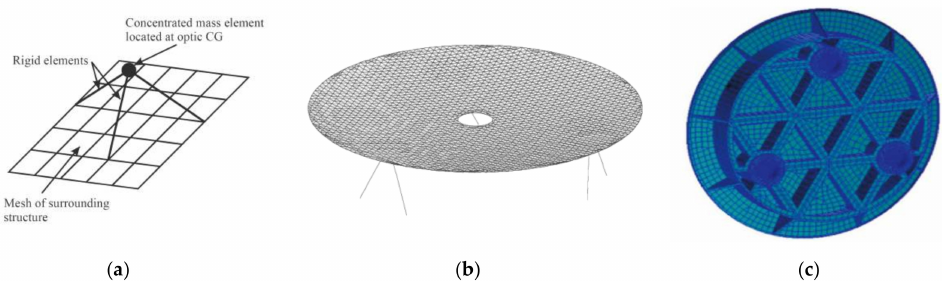
Figure 1. Simplified method of finite element modeling of a space mirror: ( a ) single-point model, ( b ) 2D shell model, ( c ) 3D solid